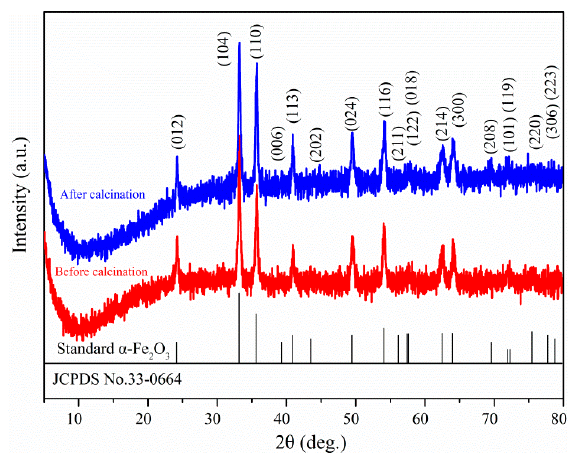
Figure 2. X-ray diffraction (XRD) patterns of α -Fe 2 O 3 @C nanoparticle composite before and after calcination.